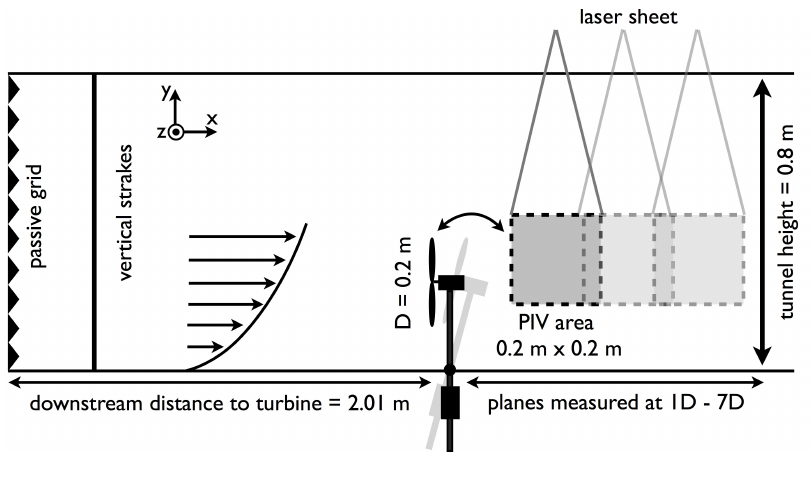
Figure 1. Wind tunnel setup. The scales are changed for visual